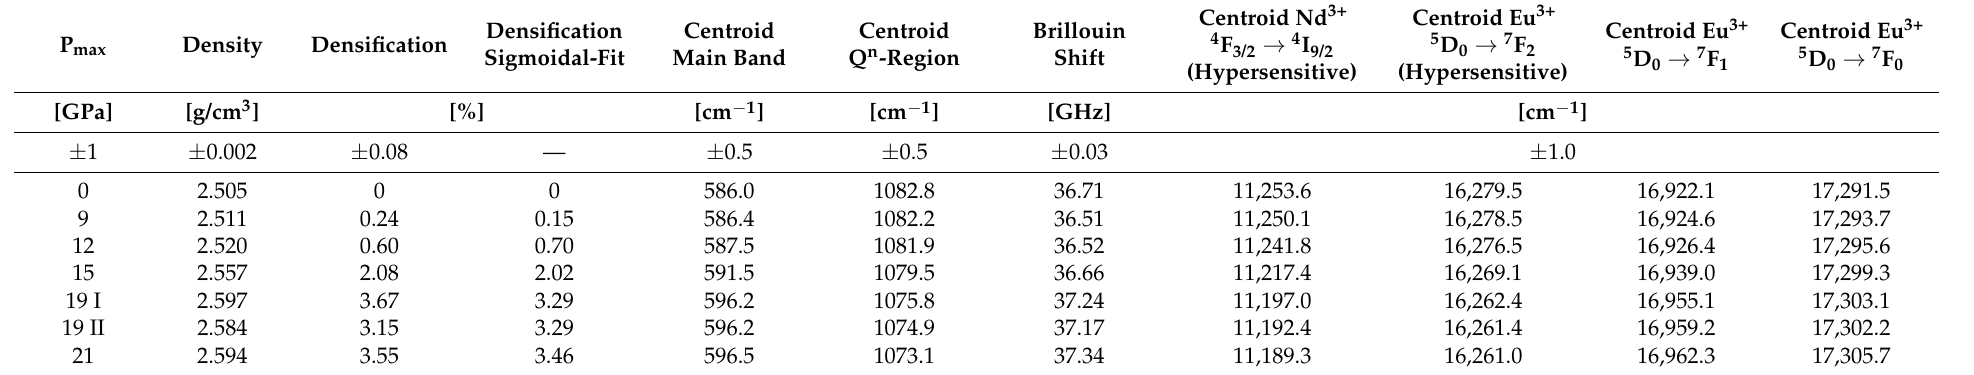
Table A3. Experimental and spectroscopic data ( centroid σ ) of the permanently densified glass cylinders.